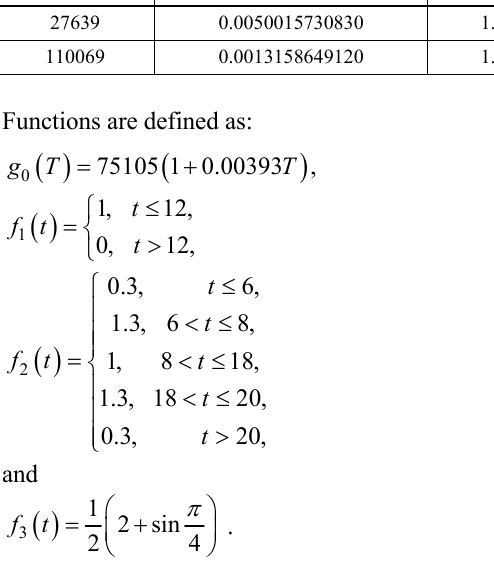
Fig. 11. The problem was solved with N = 6018 and with a fixed time step  = 0.5 h. The corresponding calculations took 3 seconds with a single core AMD Phenom™ II X6 1100T 3.3 GHz processor. The centre of the coordinates of the cables is , where i is the cable number. The assigned as x Ci corresponding dynamical functions of temperature in the , t ) are presented in Fig. 12, Fig. 13 centres of the cables T ( x Ci and Fig.